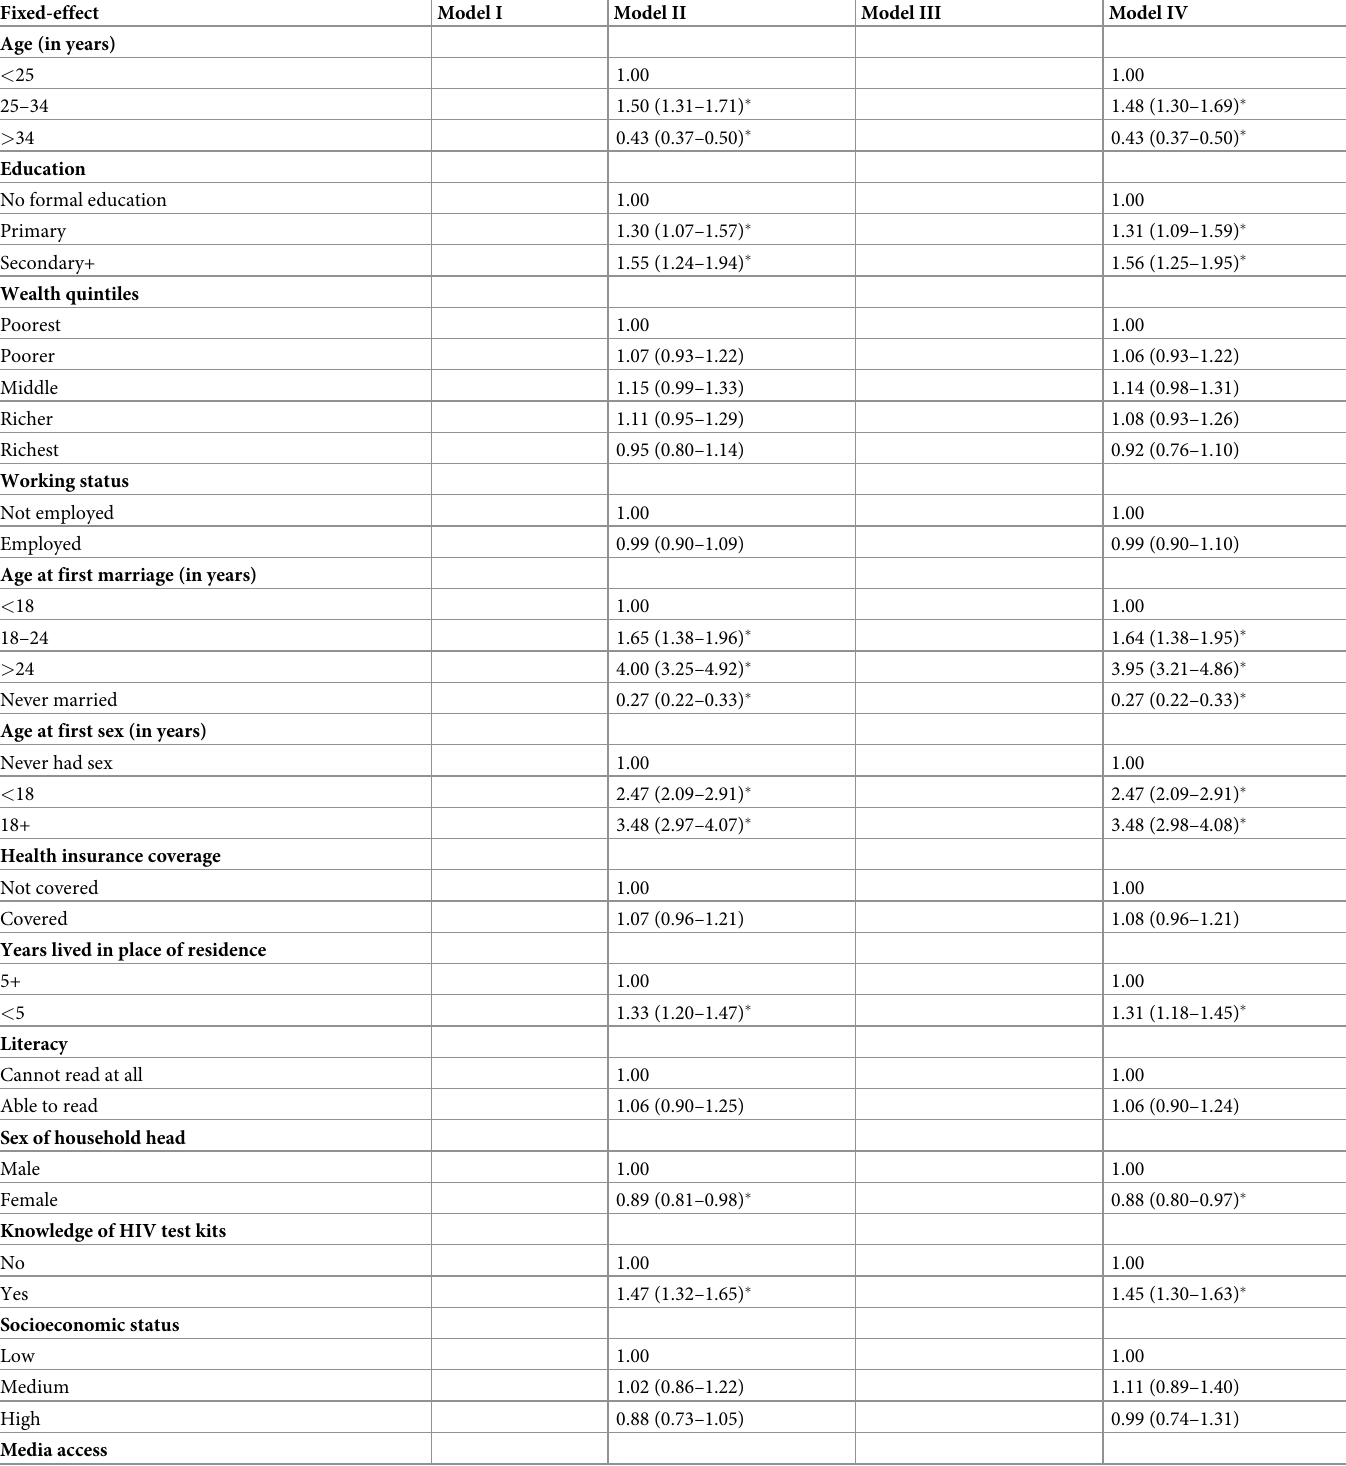
Table 3. Fixed effect of individual compositional and community-level factors associated with prenuptial HIV/AIDS testing among reproductive-aged women in